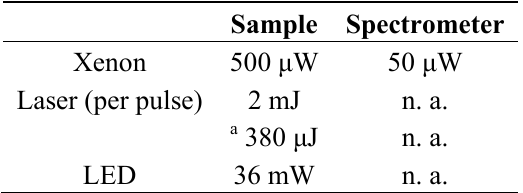
Table 2. Power and pulse energies of light sources measured at the sample—S (Figure 2), and at the entrance of the spectrometer (right before mirror M2 in Figure